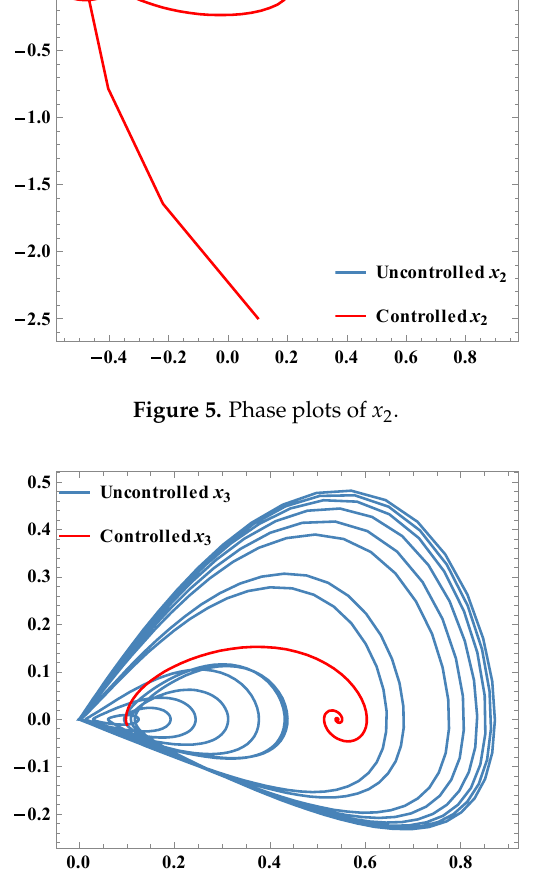
Figure 6. Phase plots of x 3 .